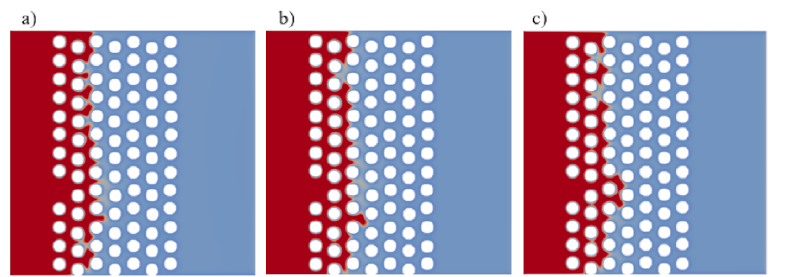
Figure 6. Gaseous phase (red) penetration for circular pores at t ∗ = 0.175 with different C a : ( a ) C a = 0.038; ( b ) C a = 0.076; ( c ) C a = 0.115.